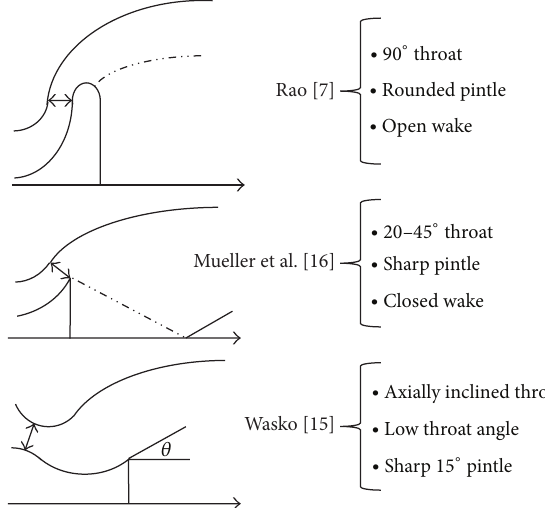
Figure 3: Expansion-deflection nozzle design